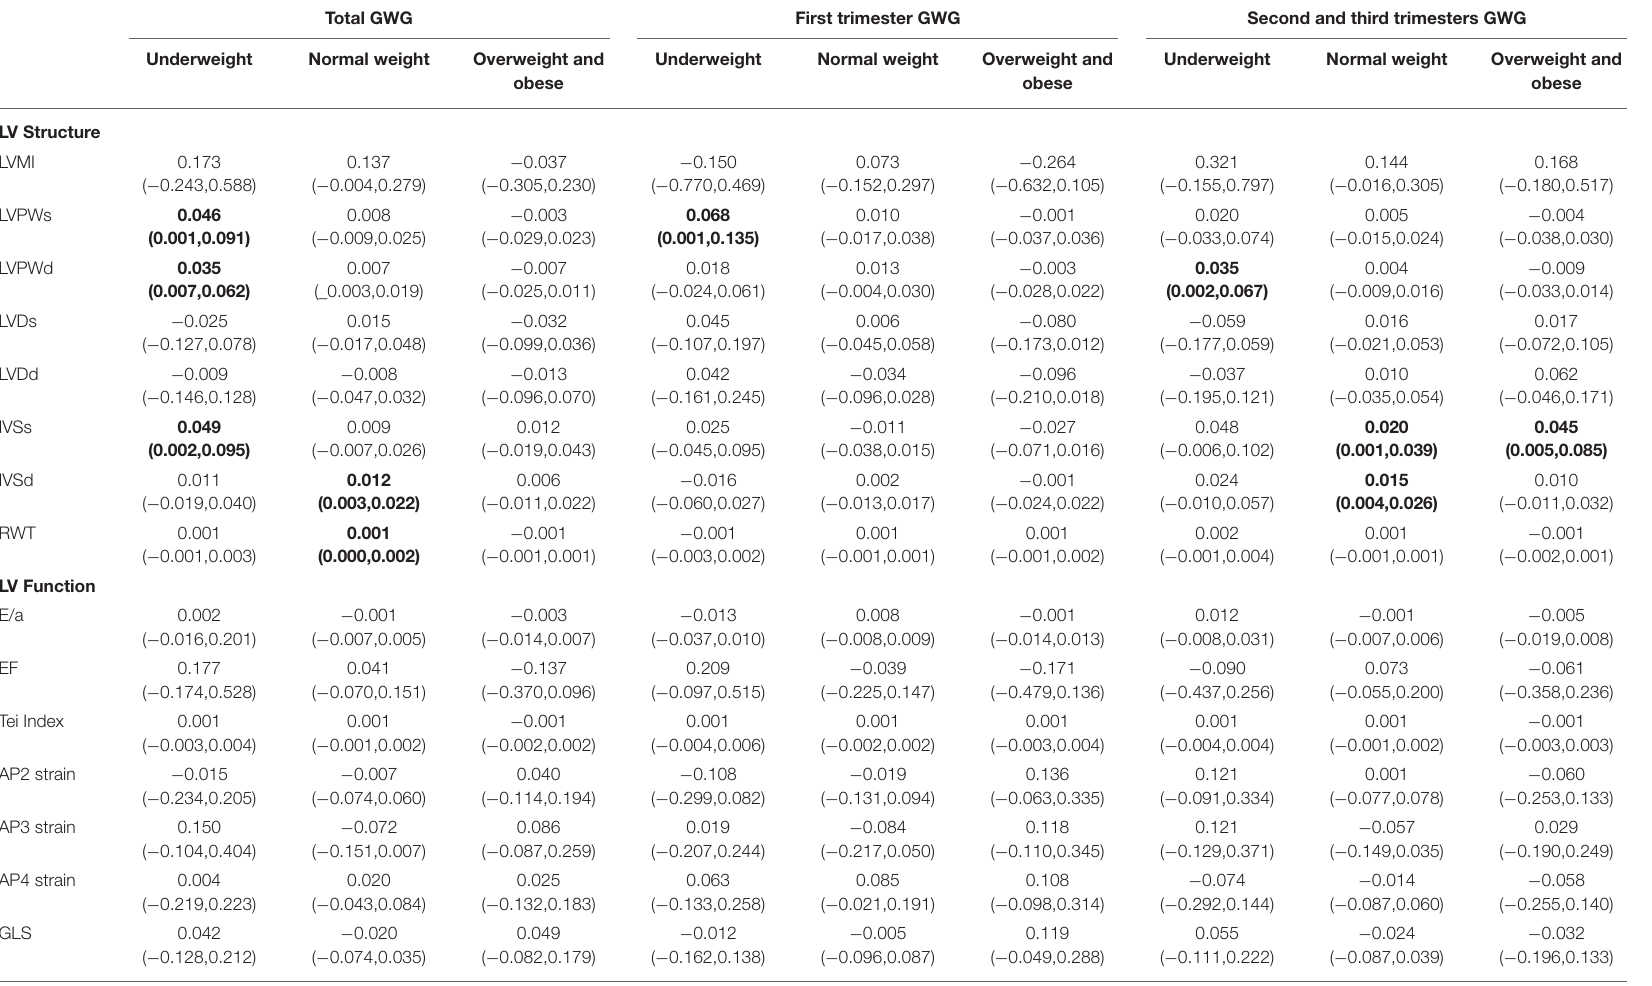
TABLE 4 | Association between maternal GWG and LV geometry and function in offspring divided by pre-pregnant